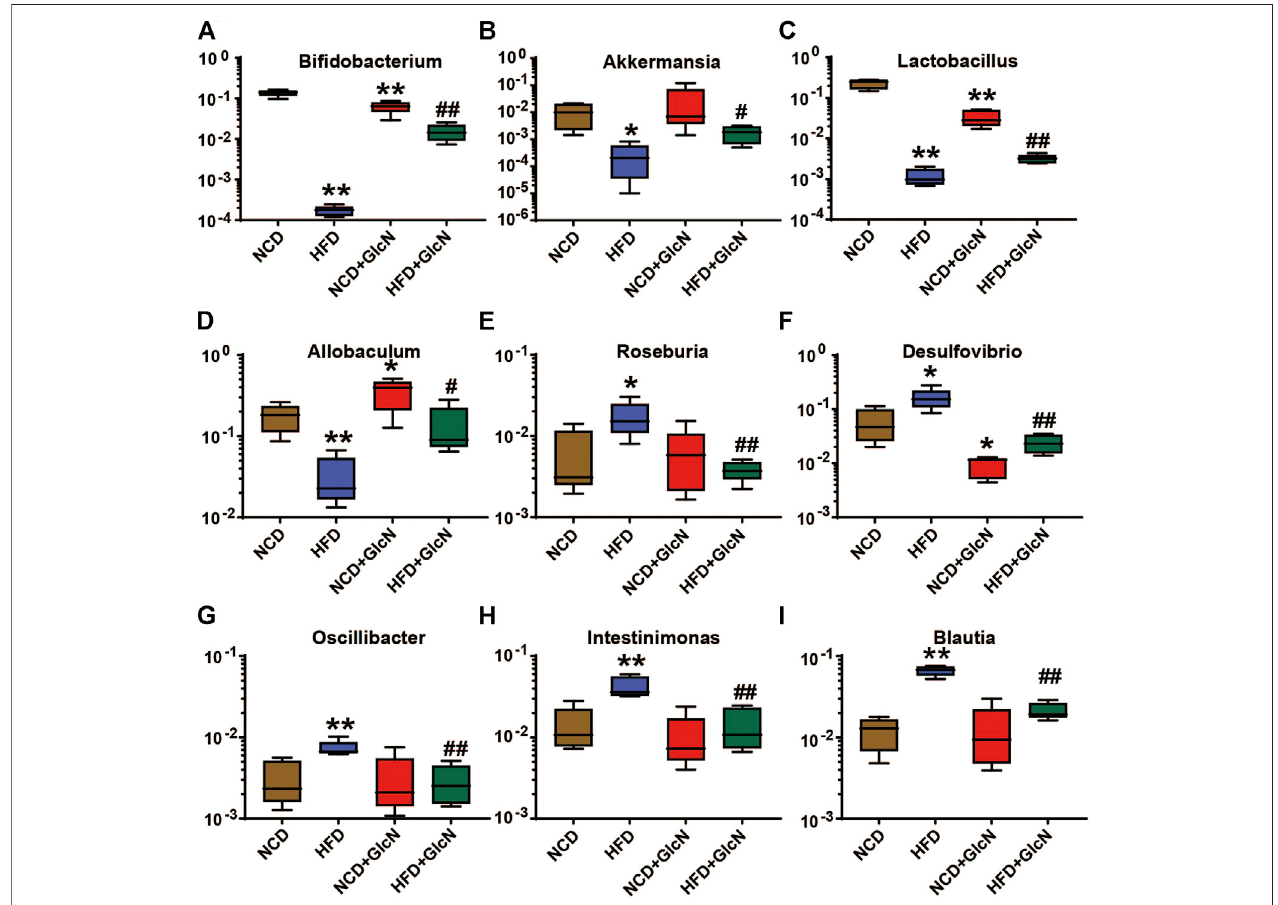
FIGURE 4 | Effect of GlcN treatment on relative abundances of gut microbiota in HFD-fed mice at the genus level, including Bi fi dobacterium (A) , Akkermansia (B) , Lactobacillus (C) , Allobaculum (D) , Roseburia (E) , Desulfovibrio (F) , Oscillibacter (G) , Intestinimonas (H) , and Blautia (I) . Data were shown as means ± SEM ( n (cid:1) 5). * p < 0.05,** p < 0.01indicatesthedifferencebetweenHFDgroupandNCDgroup; # p < 0.05, ## p <